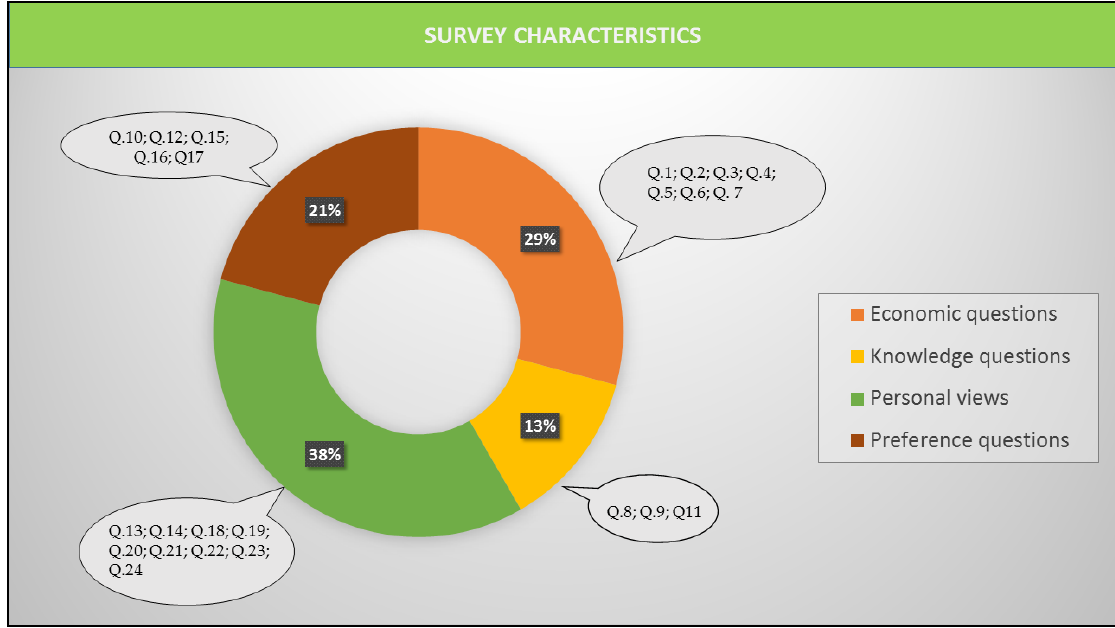
Figure 2. Categories of the questions raised in the survey, based on their relative weight in the survey. The numbers corresponding to the survey questions (Q1 – Q24) are represented in the speech bubbles .